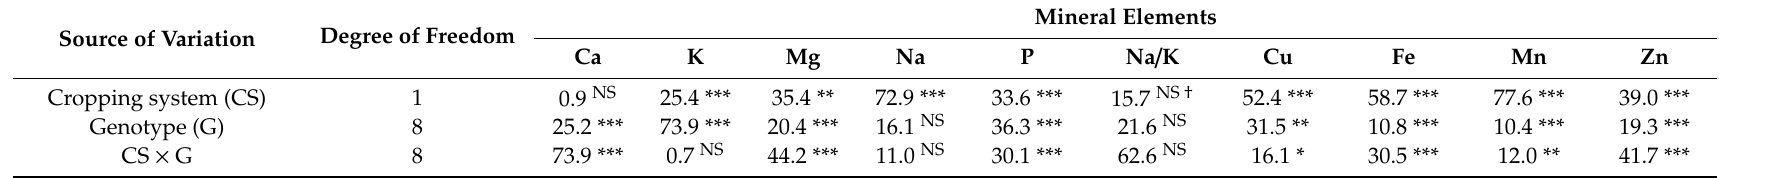
Table 6. Mean square per each source of variation (percentage of total) resulting from the analysis of variance.